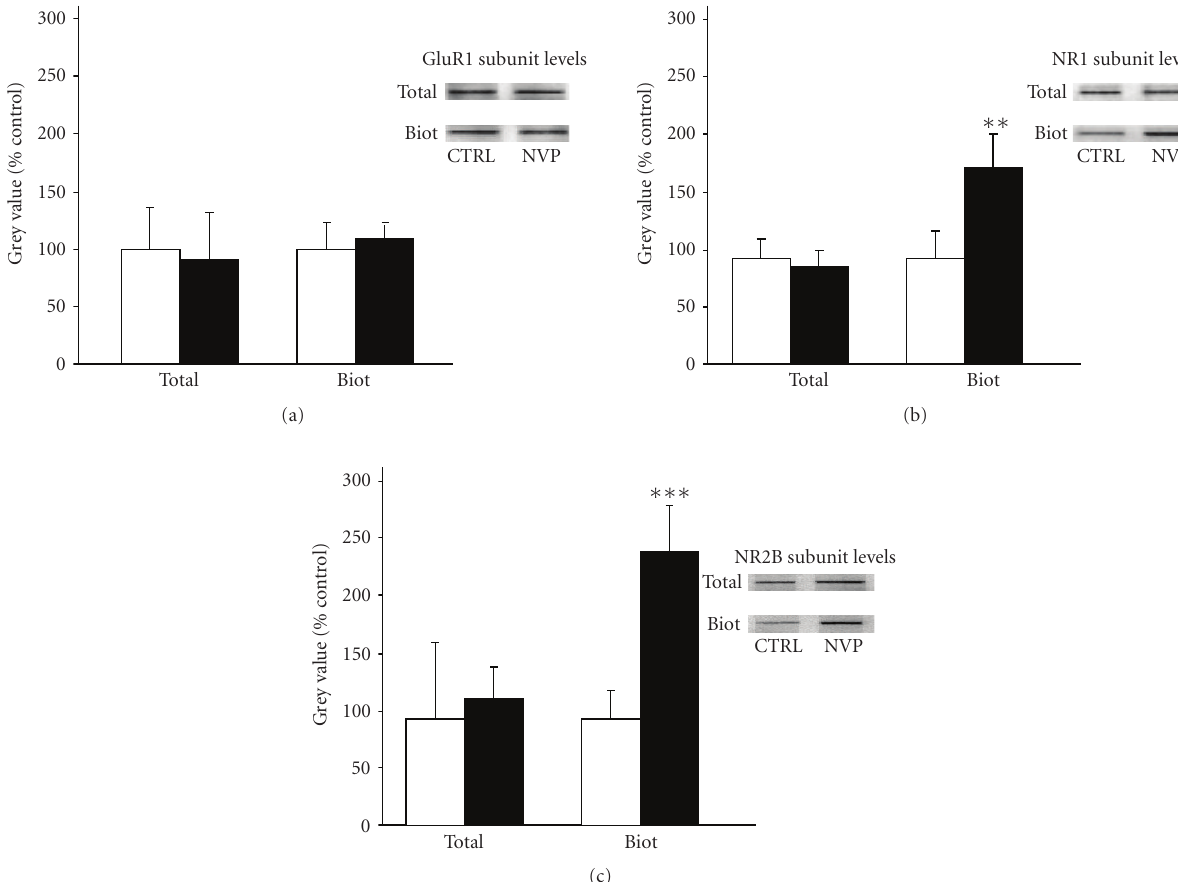
Figure 5: Blockade of NR2A-containing NMDA receptors is associated with increased levels of NR1 and NR2B subunits in biotinylated membranes. Glutamate receptor subunit levels were estimated by Western blotting on biotinylated membranes obtained from acute hippocampal slices treated with 50 nM NVP for 2 hours. Biotinylated NR1, NR2B and GluR1 subunit levels were normalized with respective total protein levels estimated in homogenates of hippocampal slices incubated with or without NVP. The data are means ± SEM of 3 measurements obtained from 4 di ff erent rats. Since these experiments were independently performed, we determined statistical significance using unpaired T -Test. ∗∗ P < . 01, ∗∗∗ P < . 001, NVP-treated versus